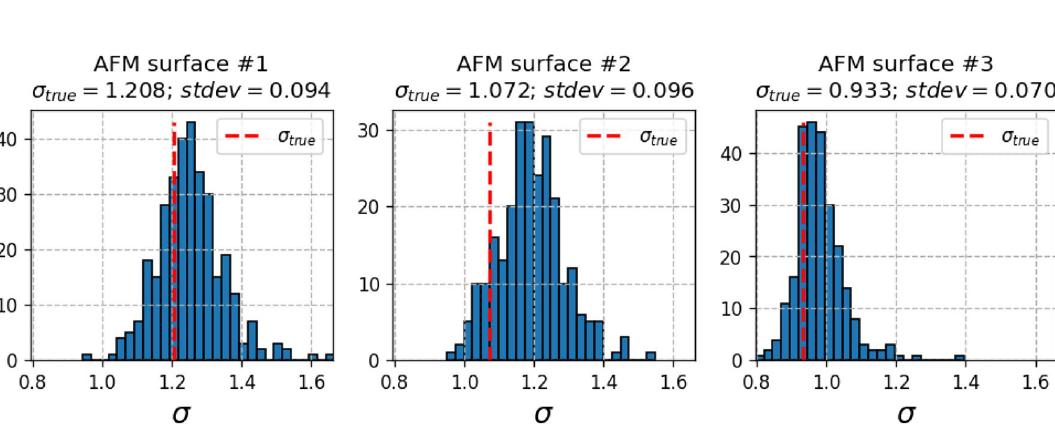
Figure 4. Histograms of standard deviations ( σ ) of normalized Voronoi sector areas (multiplied by defect density N def ) computed for synthetically generated defect distributions. Red dashed lines—Voronoi sector areas of true defect